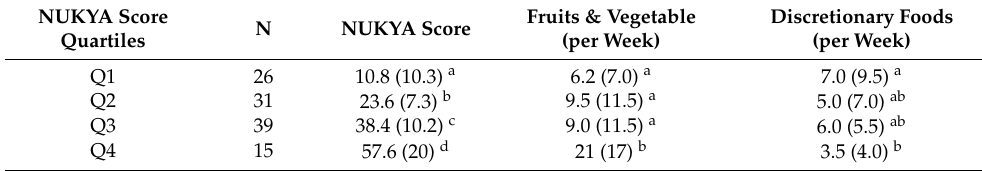
Table 5. Medians (interquartile ranges) of NUKYA scores and frequencies of consumption of fruit and vegetables and discretionary foods in a random subsample of athletes ( n = 111). In each column, different superscript letters indicate statistically significant differences between median frequencies of intake ( p < 0.05). Fruits & Vegetable (per